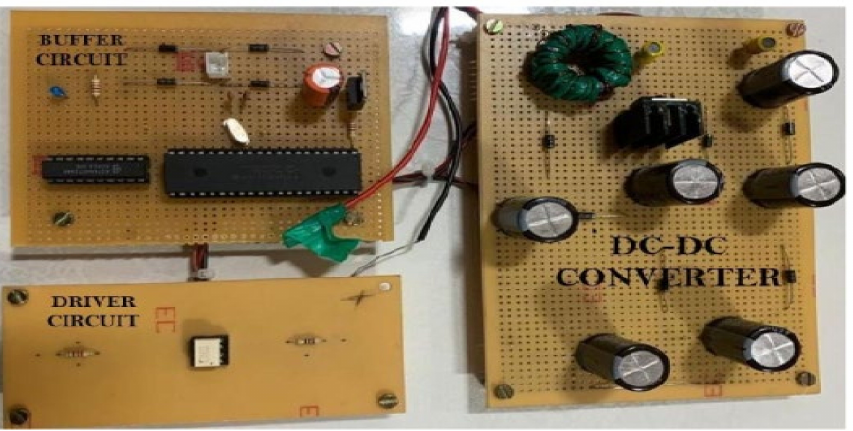
Figure 9. Experimental setup of proposed converter. Figure 10a,b depicts the input/output voltage and current waveforms of the proposed converter.